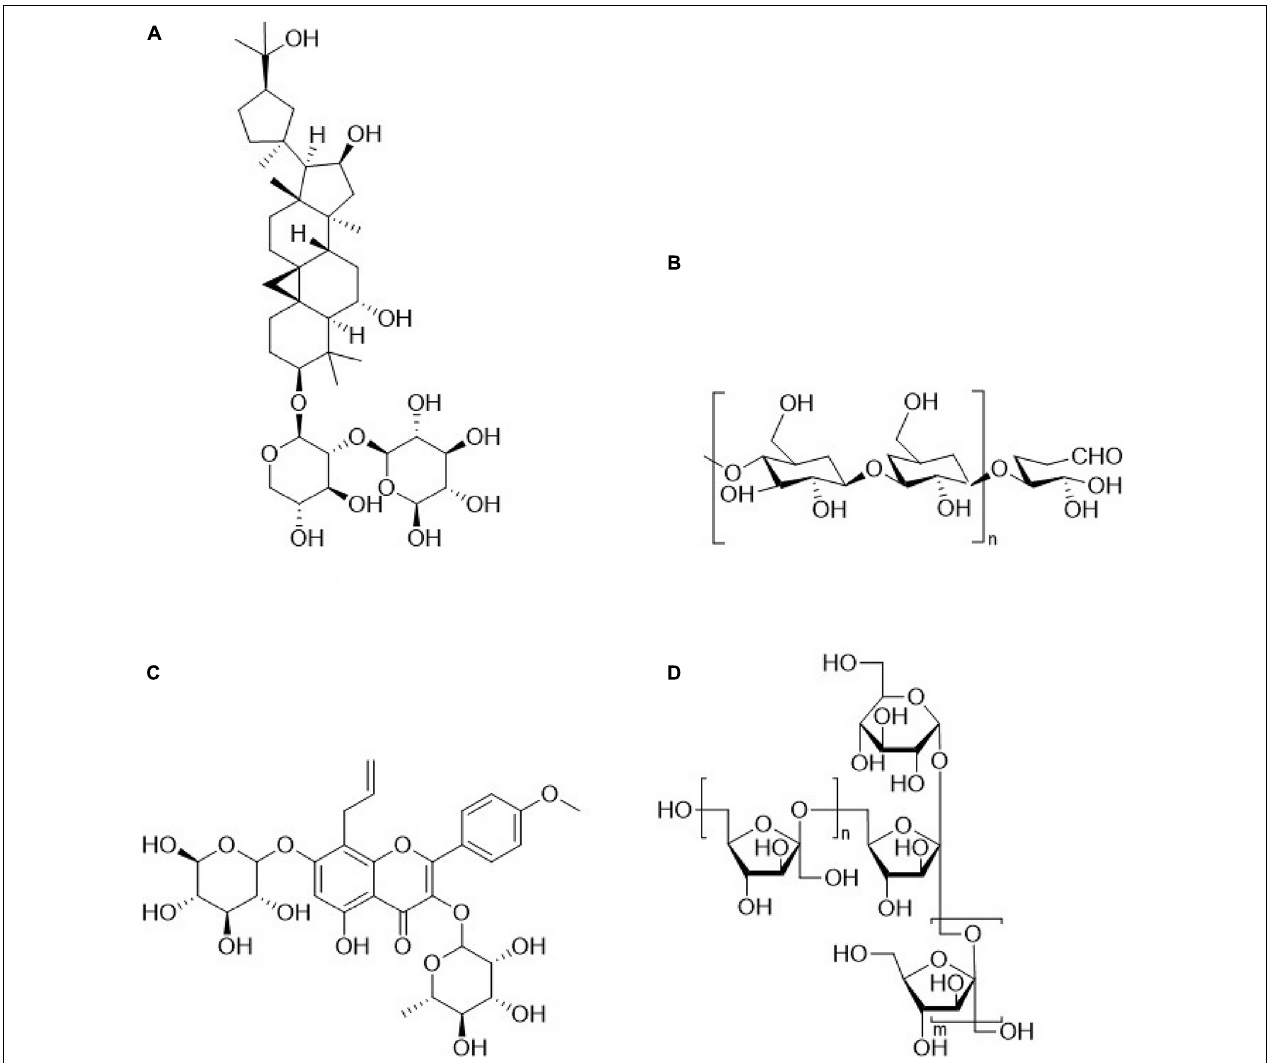
FIGURE 1 | Structural formula of Traditional Chinese medicine polysaccharide. (A) Astragalus polysaccharides. (B) Ganoderma lucidum polysaccharides. (C) Epimedium polysaccharides. (D) Achyranthes